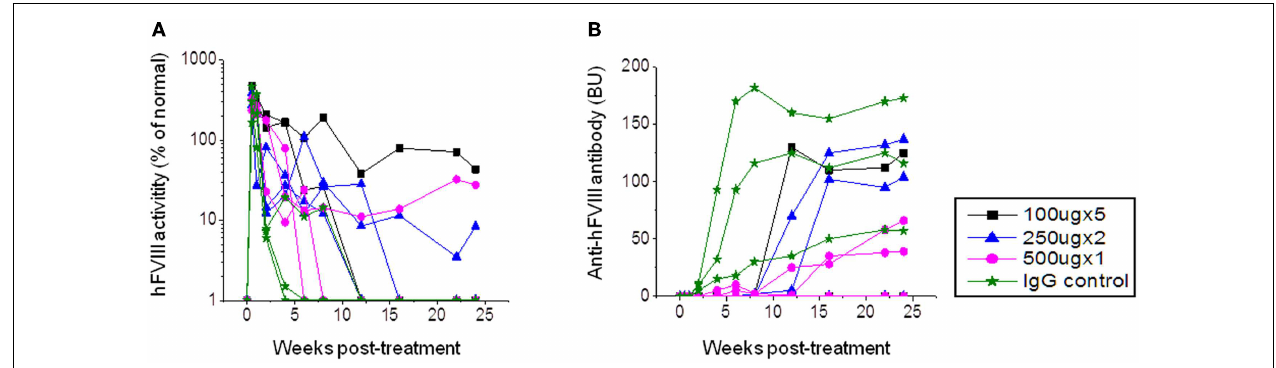
injected at days 0 and 14. Group 3: 500 µ g/treatment/mouse, injected at day 0. Group 4: control rat IgG, 250 µ g/treatment/mouse, injected at days 0 and 14. Peripheral blood samples were collected at different time points to examine FVIII activities (A) and inhibitor titers (B) . Each symbol represents data obtained from an individual mouse. Data shown is representative of two independent